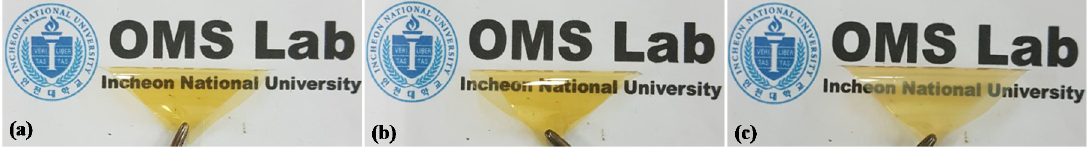
(PIM-PI)-(6FDA-durene-PI)(1:10), were prepared using the solution-casting method with CHCl 3 solution of each polymer to give flexible membranes with thickness of ~45–55 µm (Figure 3). All three membranes showed good solubility in organic solvents such as CH 2 Cl 2 , CHCl 3 , THF, and DMF, but were sparingly soluble in DMSO.